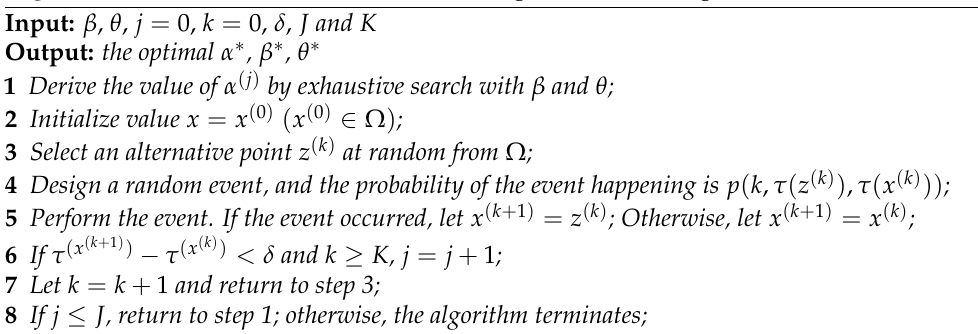
Algorithm 1 The modified simulated annealing based search